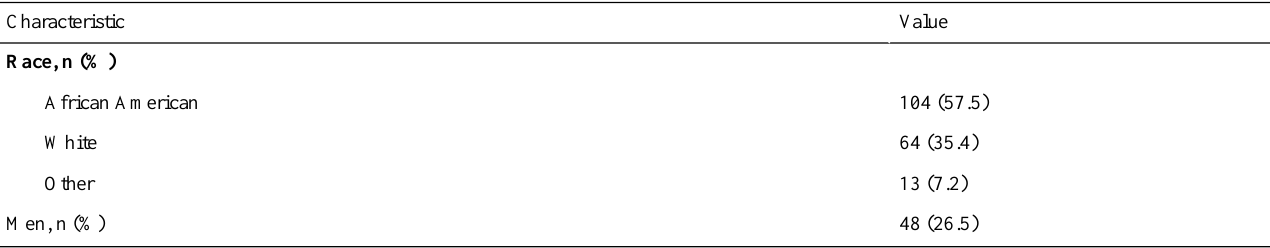
Table 1. Demographic information of patients included in our analysis